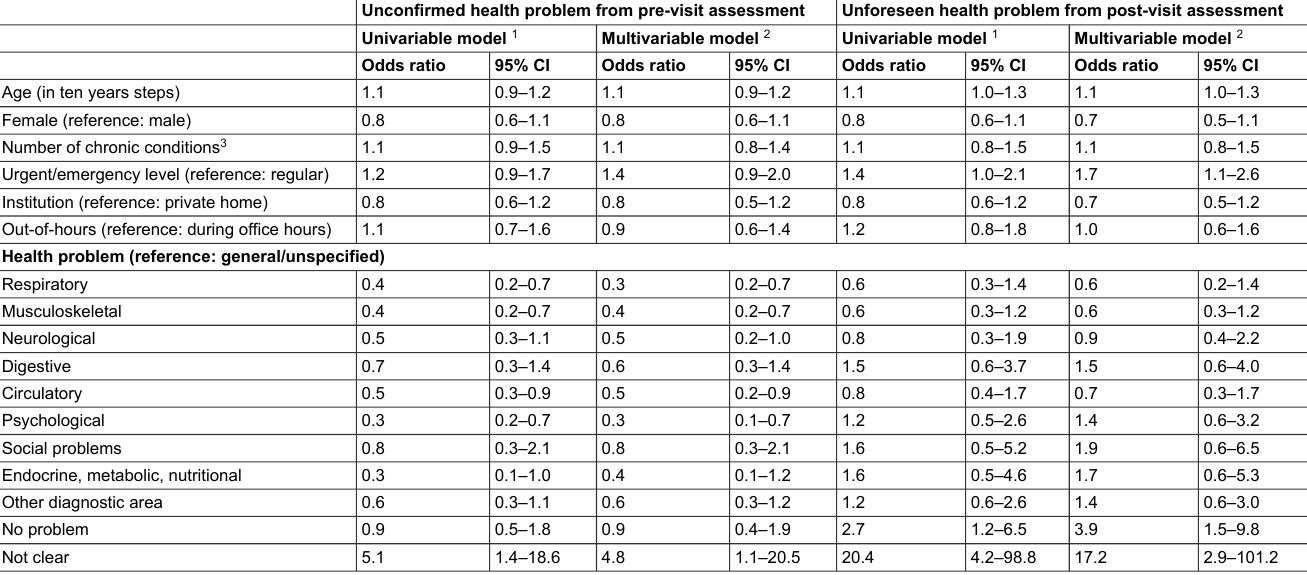
Table 2: Associations of possible red flags with unconfirmed and unforeseen health